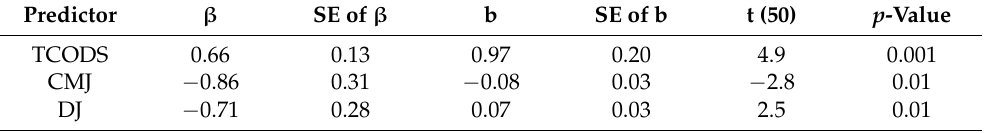
Table 4. Results of the multiple regression analysis for girls with TRAG as a criterion. Predictor β SE of β b SE of b t (50) p -Value TCODS 0.66 0.13 0.97 0.20 4.9 0.001 CMJ − 0.86 0.31 − 0.08 0.03 − 2.8 0.01 DJ − 0.71 0.28 0.07 0.03 2.5